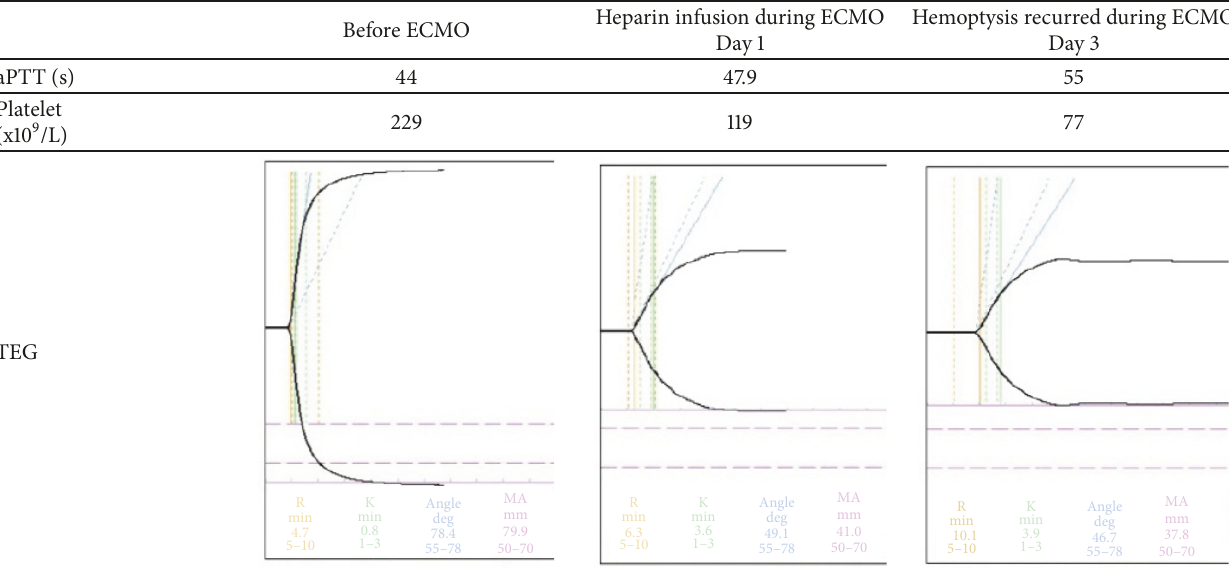
Table 1: Clotting